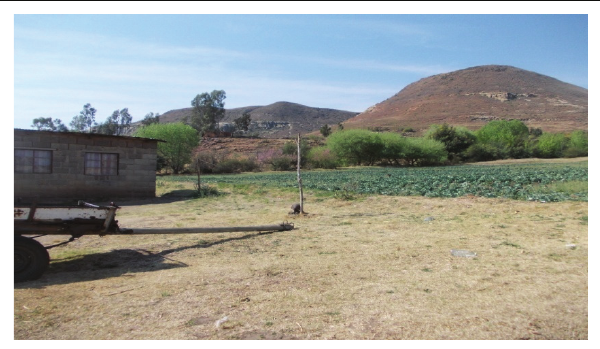
FIGURE 3: Abandoned community vegetable project at Ha Ngoae.